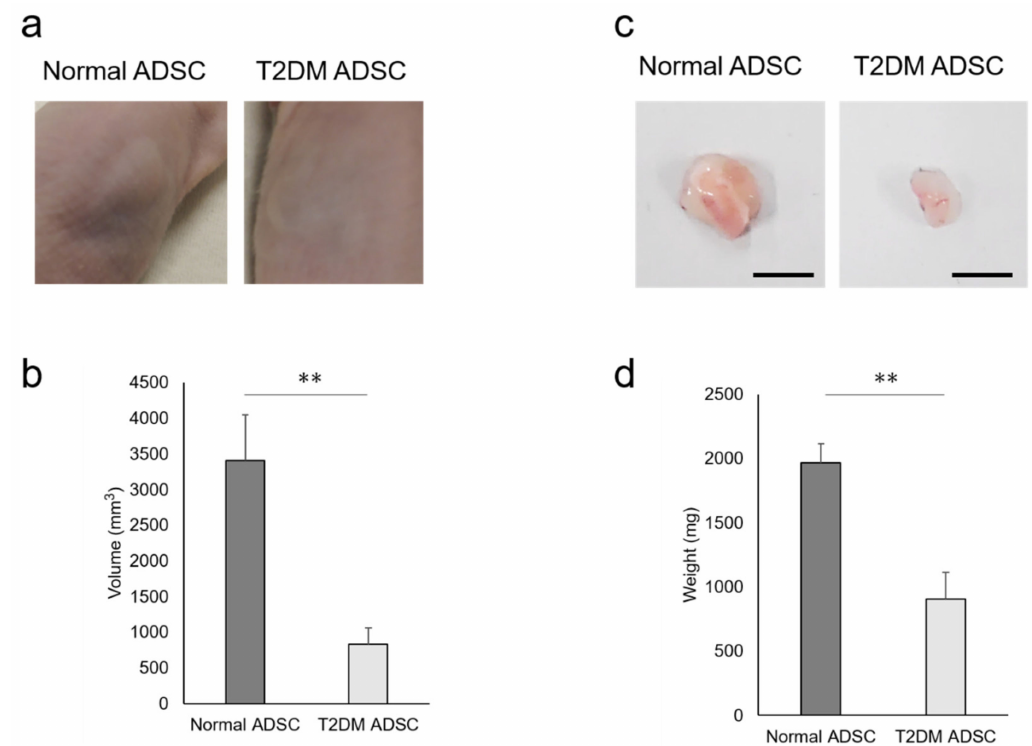
Figure 1. Evaluation of the transplantation efficiencies of ADSCs derived from patients with type II diabetes mellitus. The normal ADSCs and T2DM ADSCs were transplanted subcutaneously into the backs of immunodeficient mice. ( a ) The images of the appearances of the transplant sites in immunodeficient mice 2 weeks after the transplantation are shown. ( b ) Two weeks after the transplantation, the volumes (mm 3 ) of the transplantation sites were measured as mean ± SE. The number of samples was n = 6. The volume was evaluated three times independently. The unpaired t -test was used to test for statistical significance. ** p value = 0.006. ( c ) The images of the appearances of the skin grafts removed 3 weeks after the transplantation are shown. The scale bar indicates 10 mm. ( d ) Three weeks after the transplantation, the skin grafts were removed, and their weights (mg) were taken as mean ± SE. The number of samples was n = 6. The weight was evaluated three times independently. The unpaired t -test was used to test for statistical significance. ** p value =